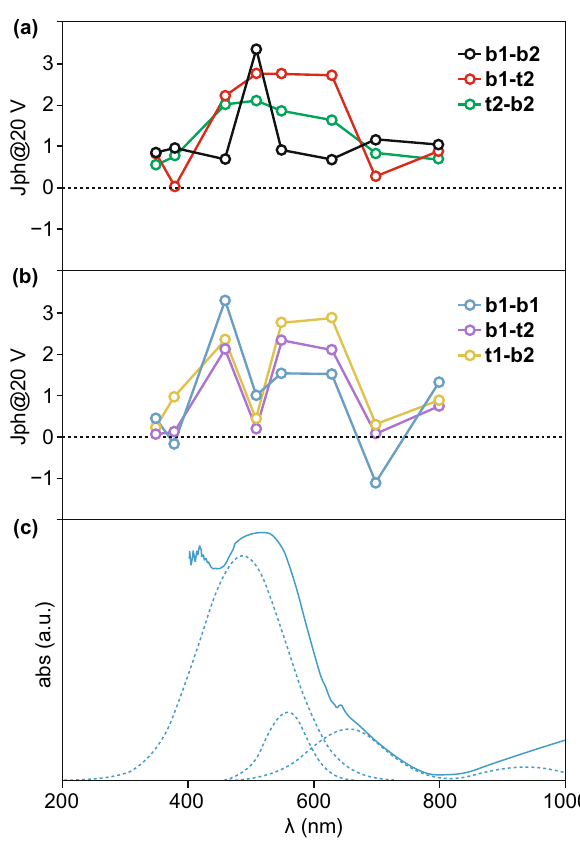
Fig. 1 a , b Photoresponse intensities at 20 V (different combinations of b1, b2 and t1, t2 stand for different crystal orientations). c Elec- tronic absorption spectrum of MOF-CoNDI-py-2. Reprinted with permission from Ref. [12]. Copyright 2017, Springer